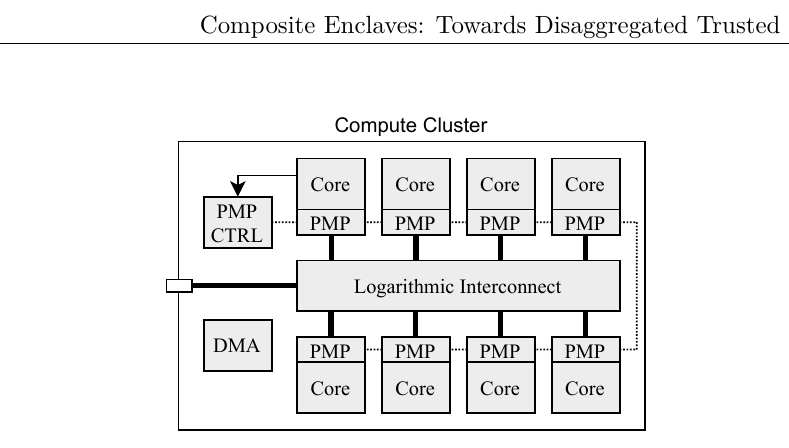
Figure 6: An architecture overview of one compute cluster of our modified accelerator with one PMP control unit per cluster and individual PMP enforcement units per